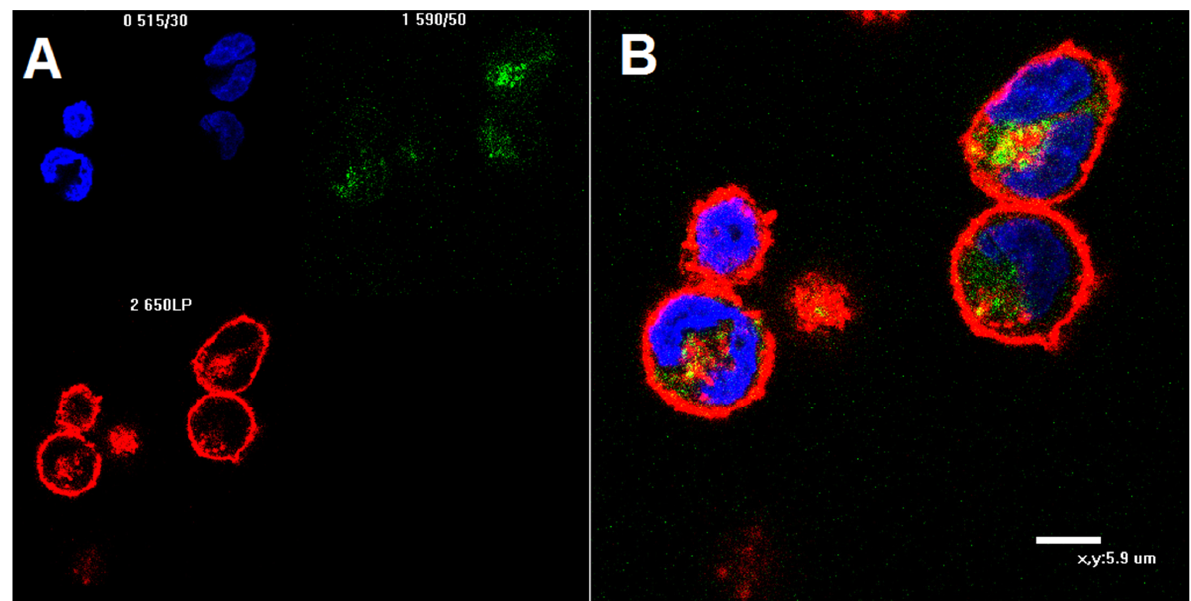
Figure 5. Confocal microscopy of K562 cells stained with AF488-labeled 6H8 antibody (green), DAPI (blue), and PKH26 (red). Single channel images ( A ), and merged channels ( B ).